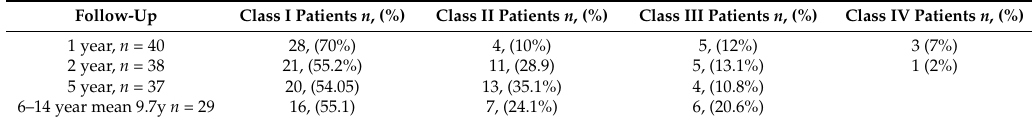
Figure 1. Long term clinical follow up using Engel Scale in temporal lobe epilepsy patients submitted to epilepsy surgery. Notice that the percentage of patients in Engel class I decreased two years postsurgery in relation to the previous year ( ★ p = 0.01, Friedman ANOVA and Sign test). There was no substantial variation for Engel class I within 24 months and the last follow up period ( p > 0.05). Table 2. Year-by-year Clinical follow up by Engel class.